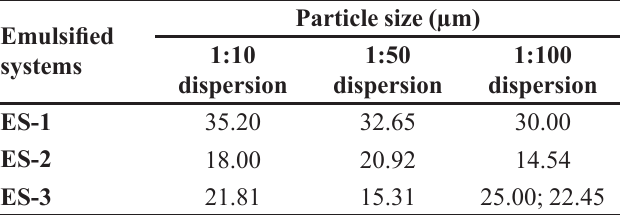
TABLE IV - Particle size of the emulsified systems droplets (regions indicated by the arrows in Figures 4, 5 and 6), obtained by optical coherence tomography Emulsified